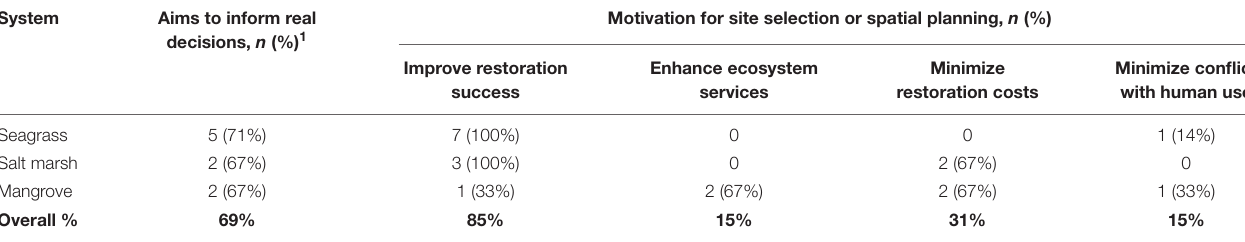
TABLE 2 | Number (and percent) of papers meeting our spatial planning criteria that specified the aims and reasons/motivations for site selection or spatial planning for restoration.